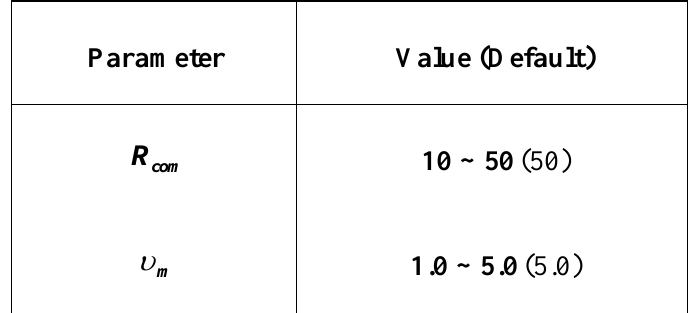
Table 2. Parameters in the